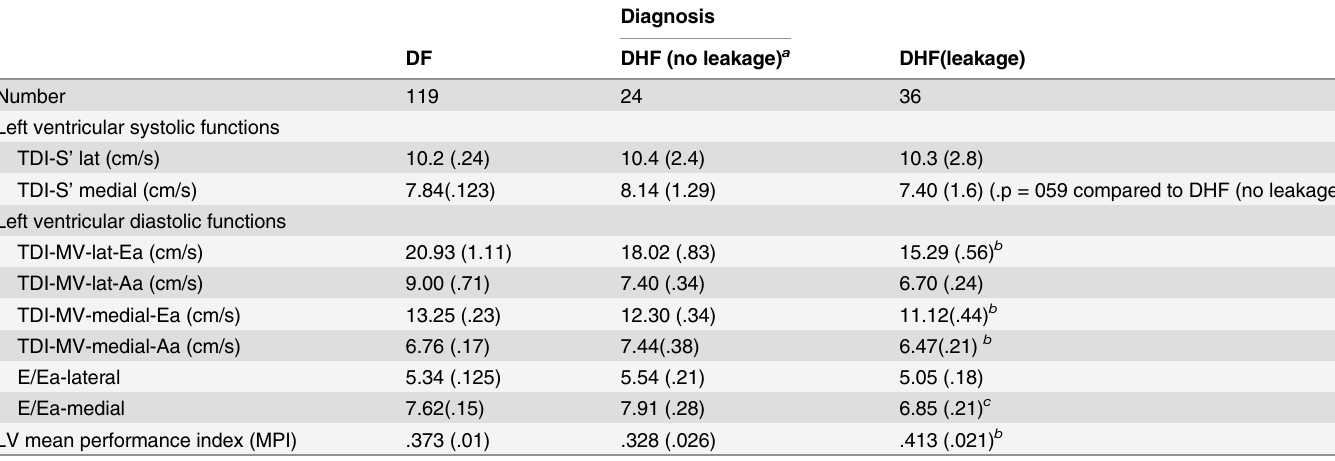
Table 3. Tissue Doppler imaging studies of LV function on the first study day in subjects with